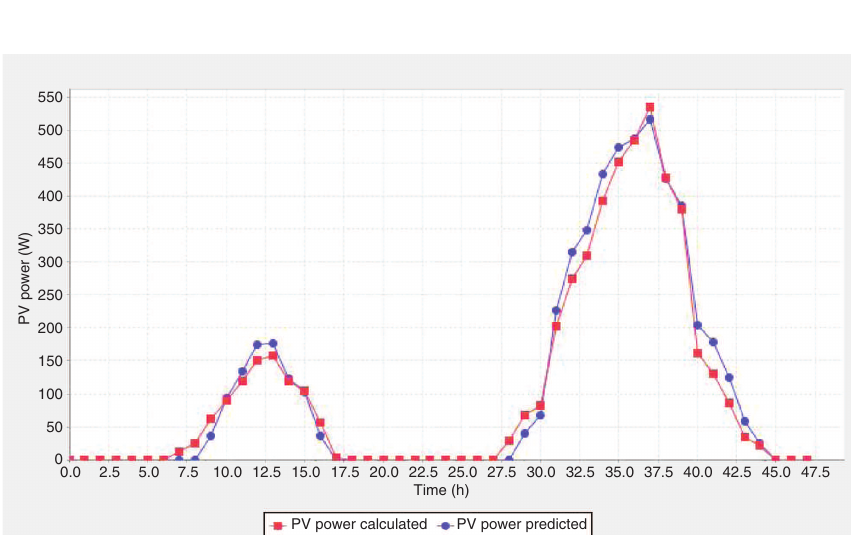
Figure 13: PV Power Predicted by ELM and Calculated by Mathematical Formula.